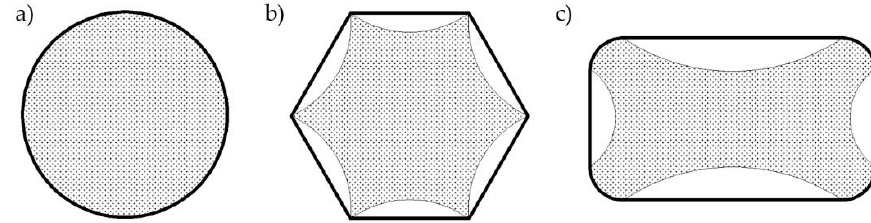
Figure 6. E ff ect of shape on confinement e ff ectiveness: ( a ) circular section, ( b ) hexagonal section, ( c ) Figure 6. Effect of shape on confinement effectiveness: ( a ) circular section, ( b ) hexagonal section, ( c ) rectangular section with rounded rectangular section with rounded corners.